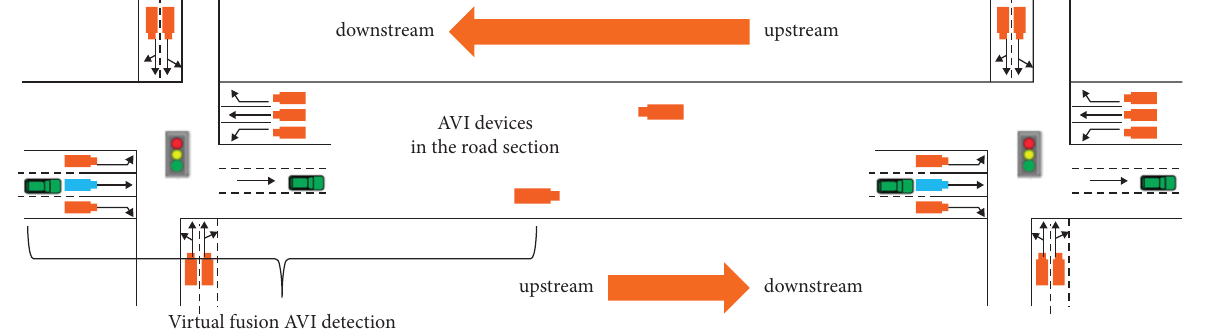
Figure 2: Virtual fusion AVI detection.